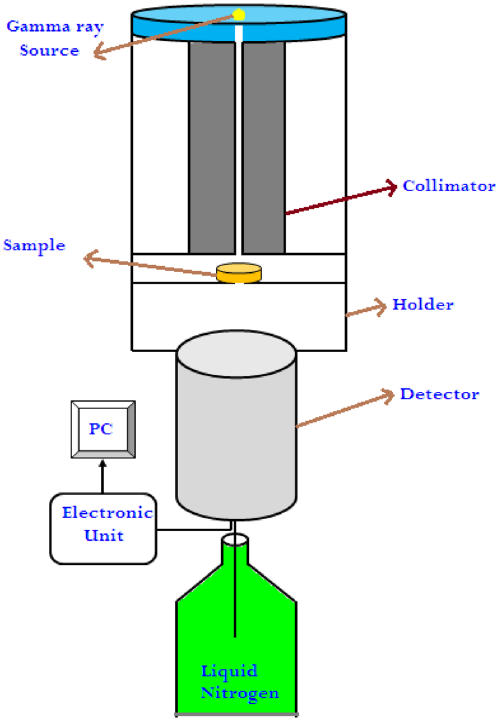
Figure 3. The experimental attenuation calculation geometry in the current